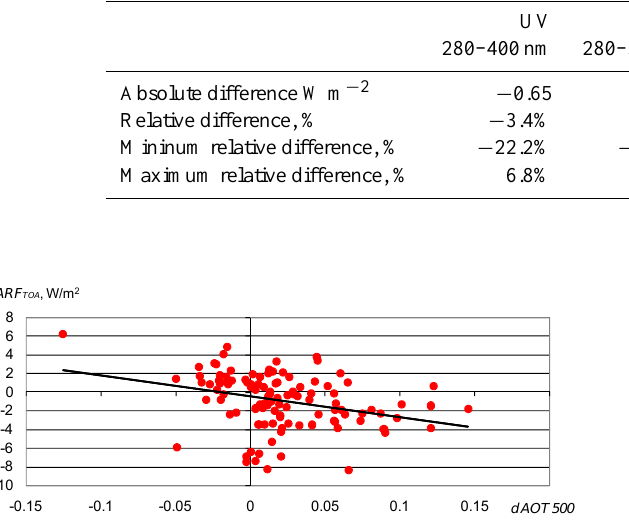
Fig. 10. Dependence of the difference in aerosol radiative forcing at TOA ( dARF TOA ) between Moscow and Zvenigorod as a function of dAOT500 .